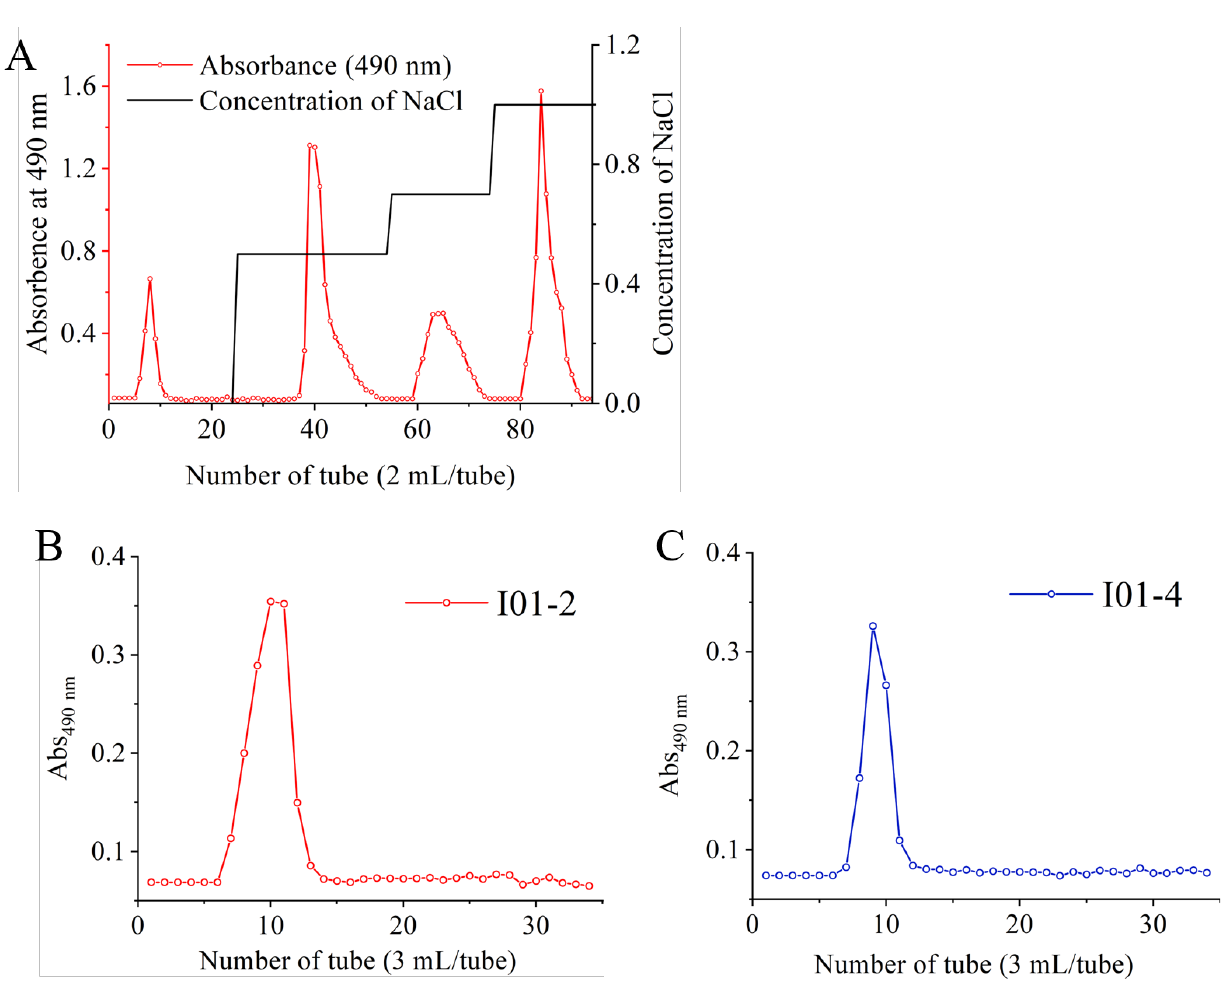
Figure 1. Elution profile of E. hirae WEHI01 crude EPS on HiTrap Q HP chromatography column with NaCl solutions (0, 0.5, 0.7, and 1 M) ( A ) and elution profile of I01-2 ( B ) and I01-4 ( C ) on Sephadex G-200 gel chromatography column with 0.2 M NH 4 HCO 3 ( B ). – ○ – , 490 nm for the detection of carbohydrate. (cid:35)